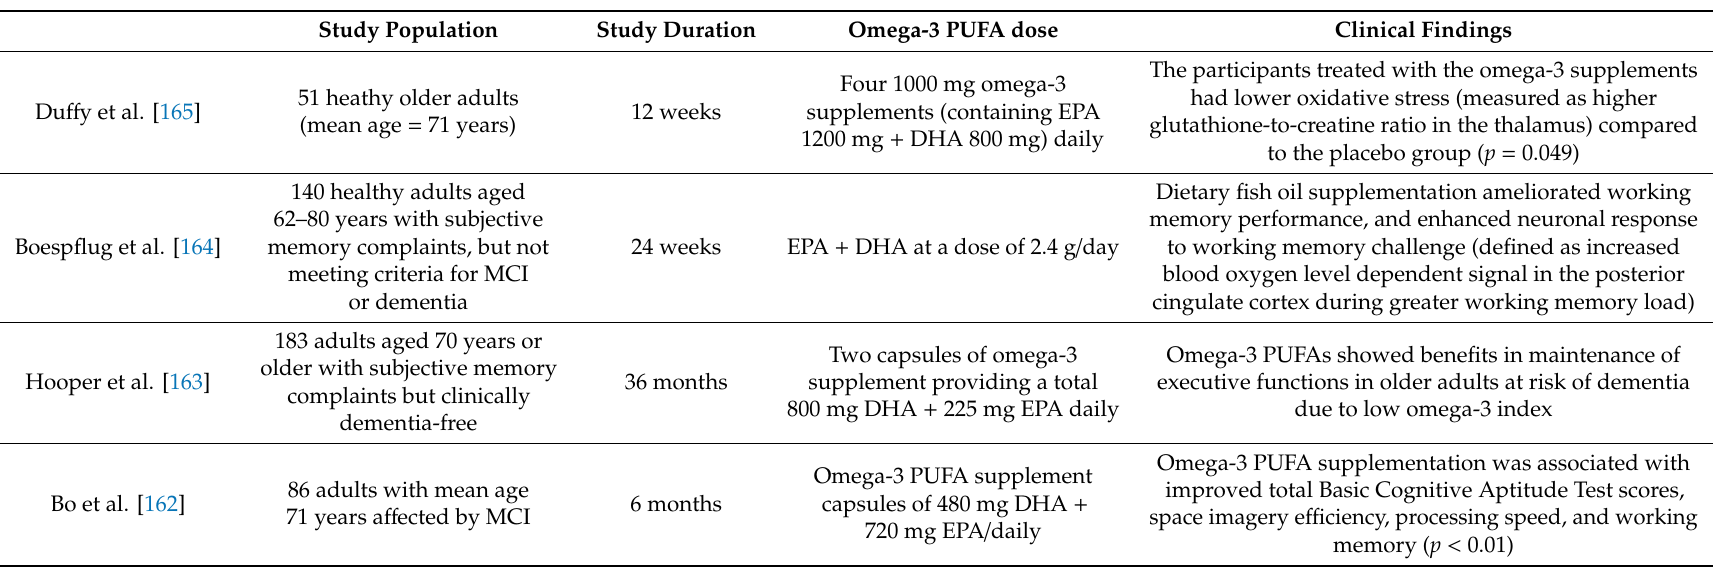
Table 2. Summary of the main randomized controlled trials assessing the e ffi cacy of omega-3 PUFAs in prevention of vascular cognitive impairment and